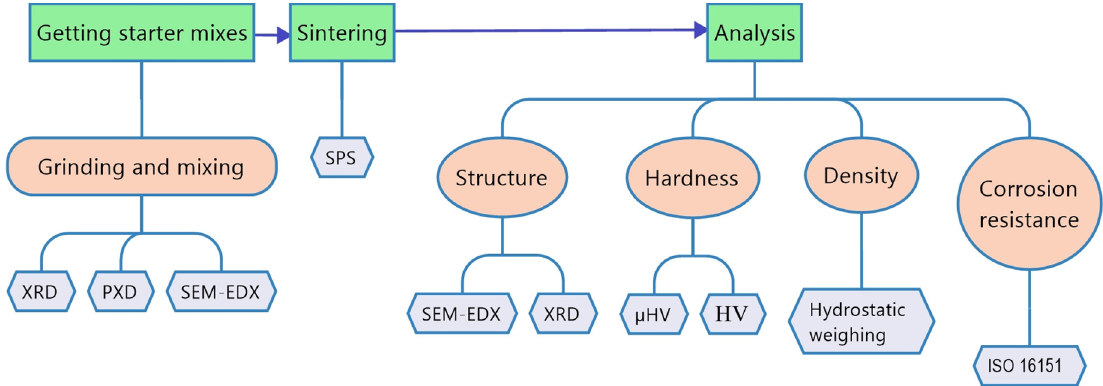
Figure 1. Scheme of the experiment.